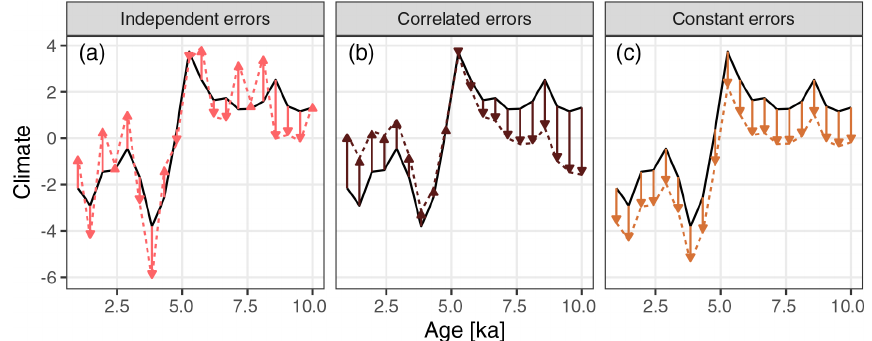
Figure 1. Illustration of different timescale dependences of proxy errors. The independent and correlated errors both have standard deviations of 1.5 ◦ C, while the constant error is 1.5 ◦ C with zero standard deviation.